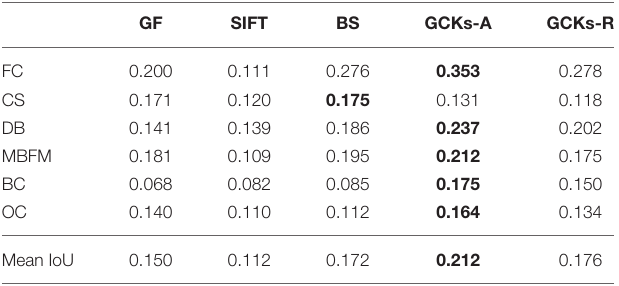
TABLE 2 | Evaluation of our motion-based pipeline on a selection of sequences from the DAVIS-2016 dataset, in comparison with classical motion detection